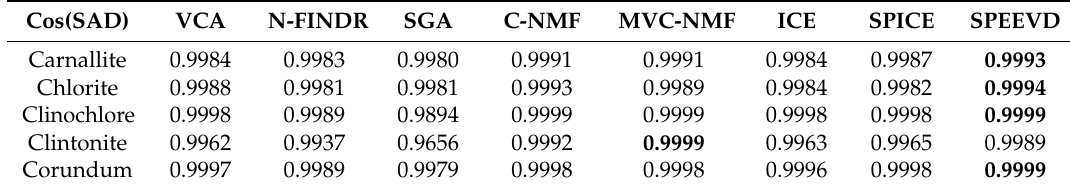
Table 2. The cosine of SAD values between the extracted endmembers and the USGS library.